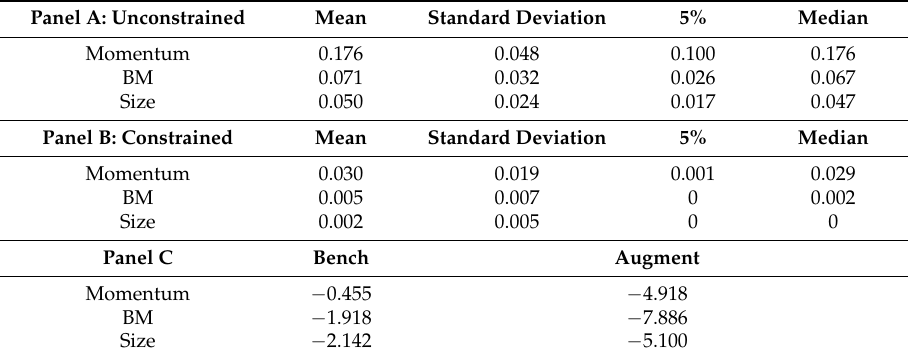
Table 6. Posterior Distribution of the DSharpe Measure Using Model 1 Characteristics: Large Stocks.